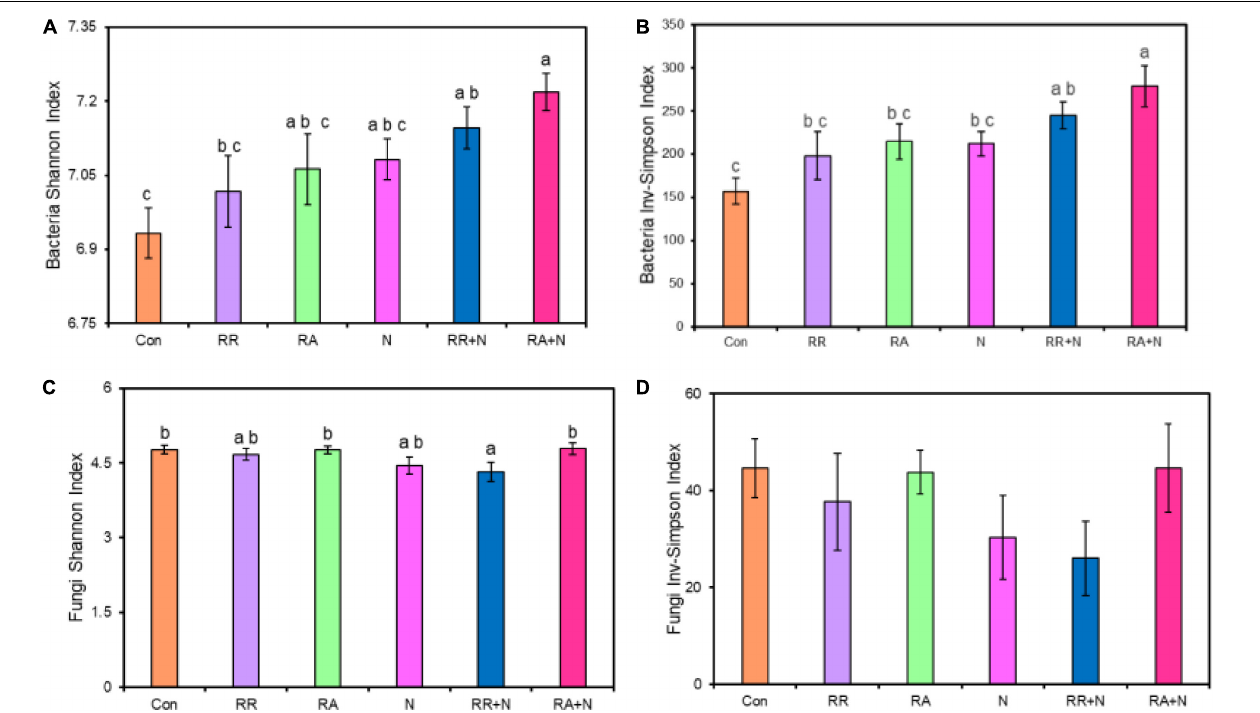
FIGURE 1 | The effects of altered nitrogen addition and rainfall, and their interaction, on bacterial Shannon index (A) and Inv-Simpson index (B) , fungal Shannon index (C) and Inv-Simpson index (D) in August 2018. Different treatments: Con: Control; RR: Rainfall reduction; RA: Rainfall addition; N: Nitrogen addition; RR + N: Rainfall reduction and Nitrogen addition; RA + N: Rainfall addition and Nitrogen addition. Values are mean ± SE ( n = 5). Different lowercase letters indicate significant differences ( p < 0.05) according to Duncan’s post hoc test.